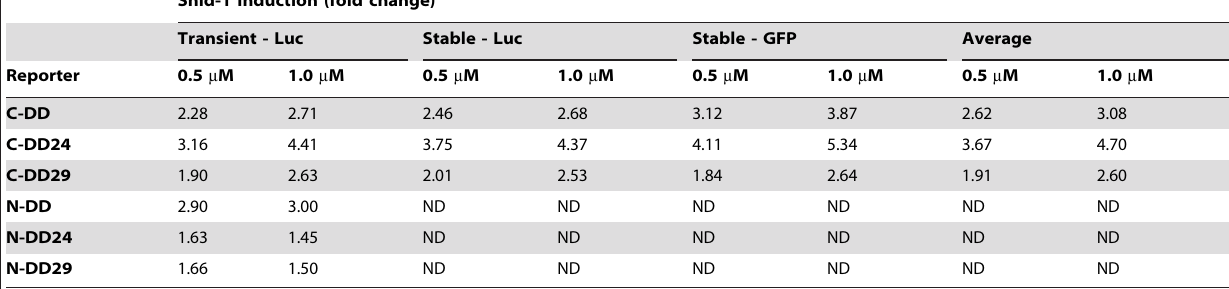
Table 1. Reporter proteins - regulation summary.